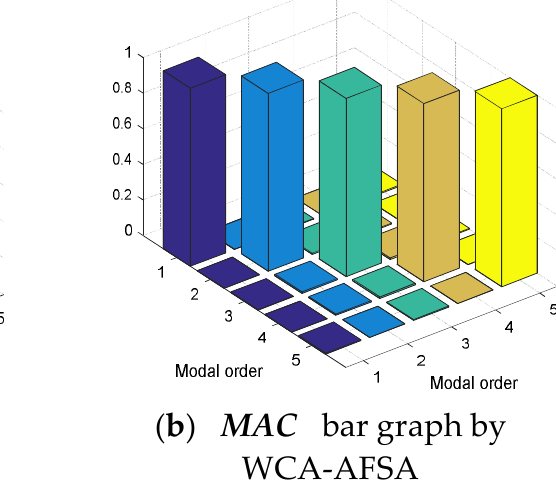
Figure 8. MAC bar graph. Figure 8 . MAC bar graph. Table 3. The values of MAC by AFSA. Table 3. The values of MAC by AFSA.